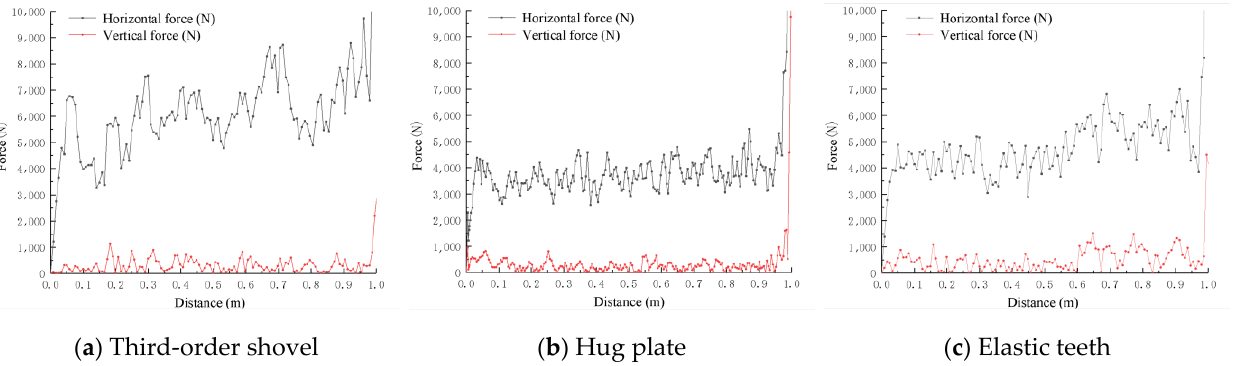
Figure 11. Forces on film-lifting parts at different